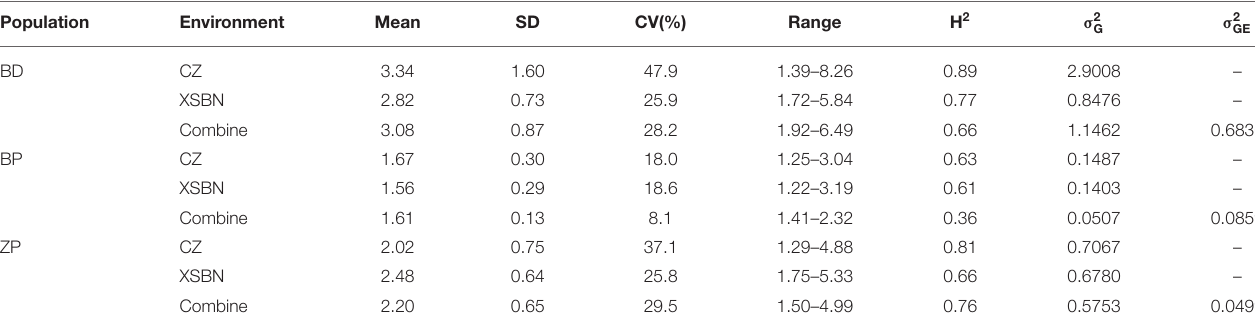
TABLE 3 | Descriptive statistics for FER resistance for three teosinte gene introgression populations.